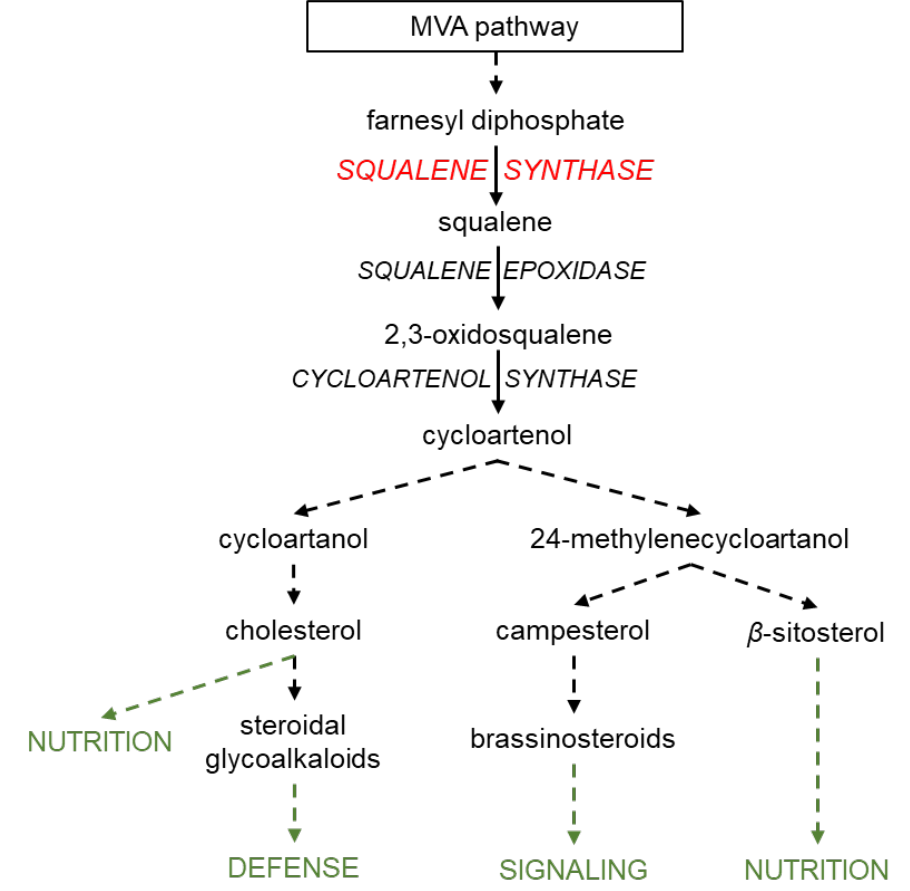
Figure 1. SQUALENE SYNTHASE catalyzes the biosynthesis of squalene, the common metabolic precursor of all known plant triterpenoids. Genes encoding metabolic enzymes are in all-capitalized, italicized letters. Dashed arrows indicate multi-step metabolic pathways.